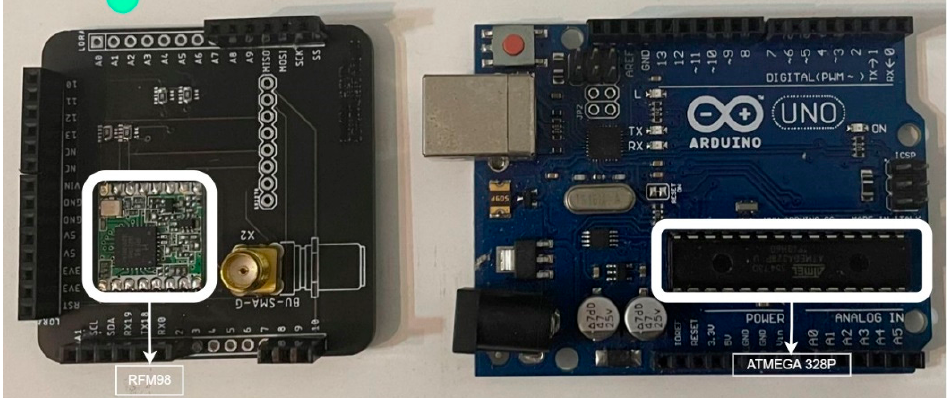
Figure 7. The hardware of end nodes setup with RFM 98 LoRa module and ATMEGA A328P Ar- duino Uno microcontroller board